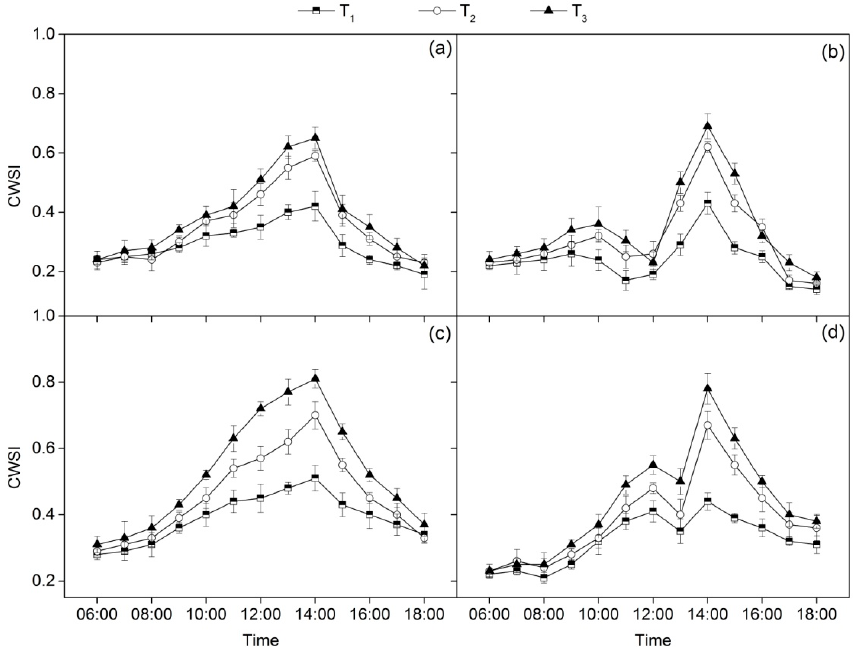
Figure 5. Daily changes of the CWSI under the three treatments during different stages. ( a ) represents the vegetative stage, ( b ) represents the flowering stage, ( c ) represents the fruit expansion stage, and ( d ) represents the coloring mature stage. Date are means ± SE of three replicates. T 1 represents 100% M, T 2 represents 80% M, T 3 represents 60%.